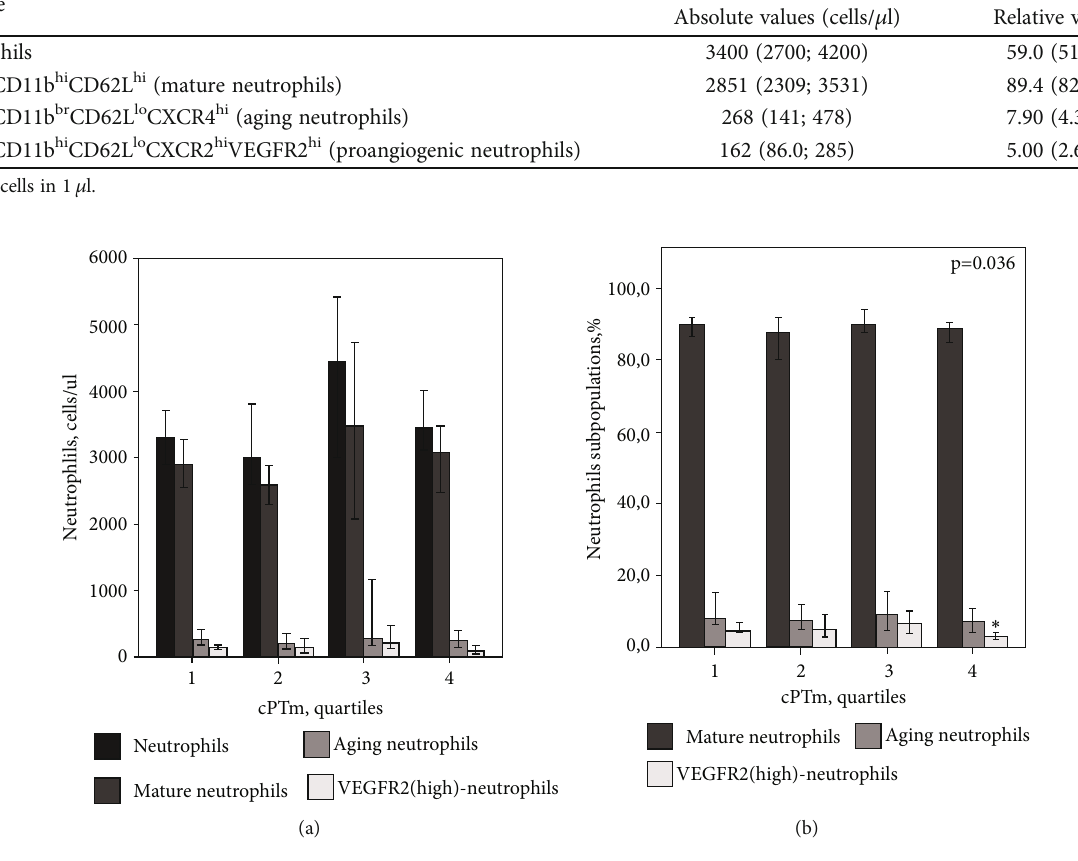
Figure 2: Absolute (a) and relative (b) neutrophil count as a function of cPTm quartile.